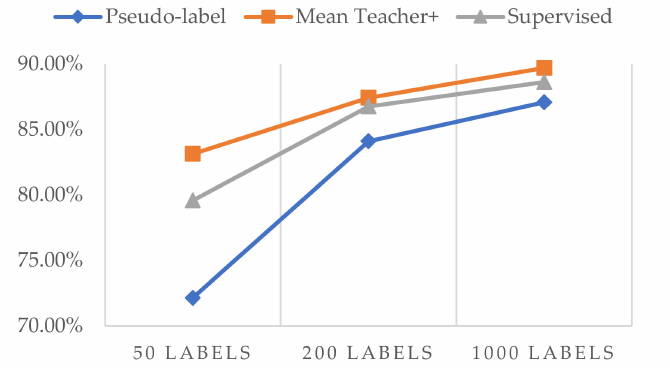
Figure 8. Accuracy of various algorithms under different labeled